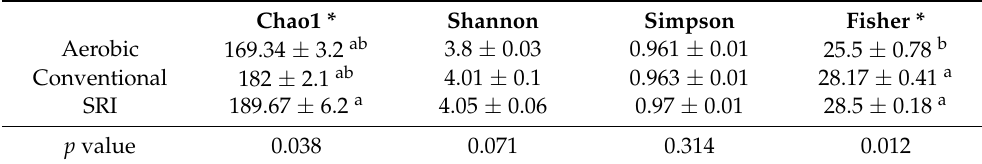
Table 4. Bacterial diversity indices of soil samples of different planting systems.